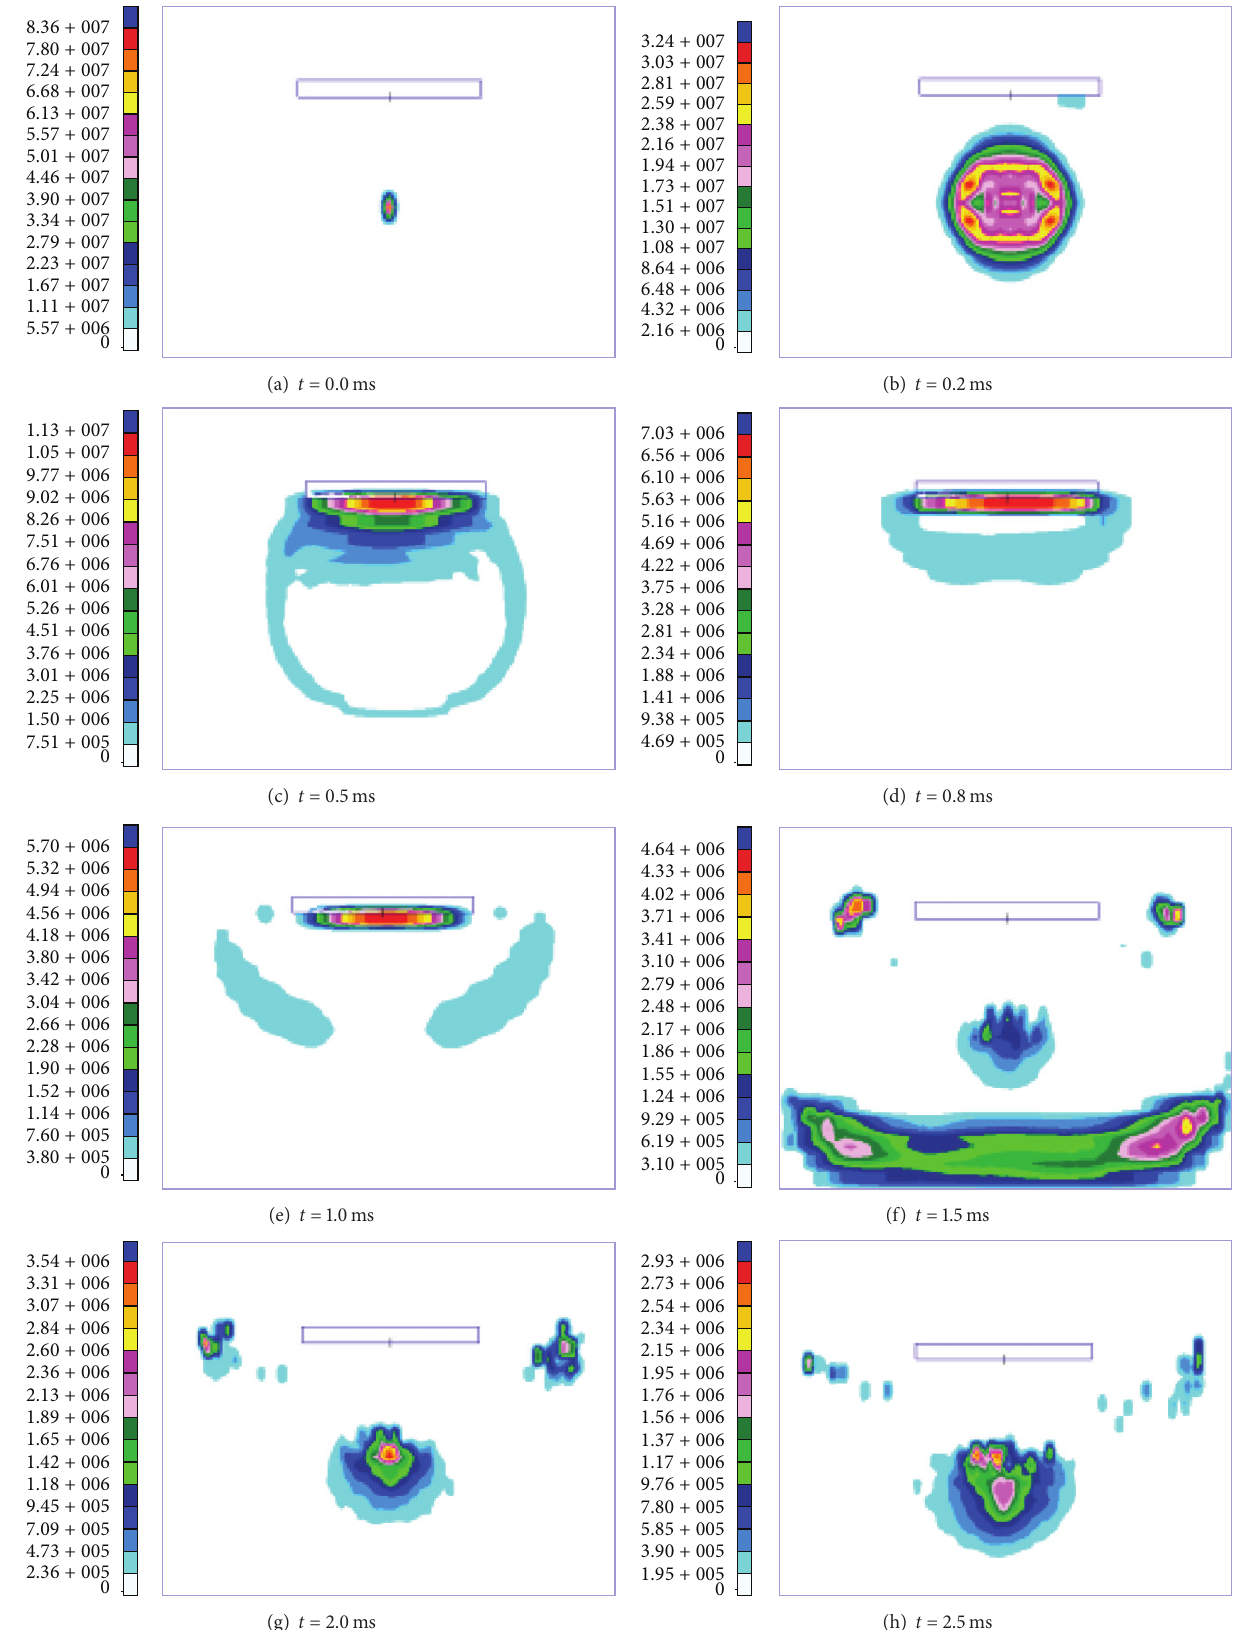
Figure 10: Bubble impact pressure contour ( 𝑊 = 0.05 kg, d = 0.6